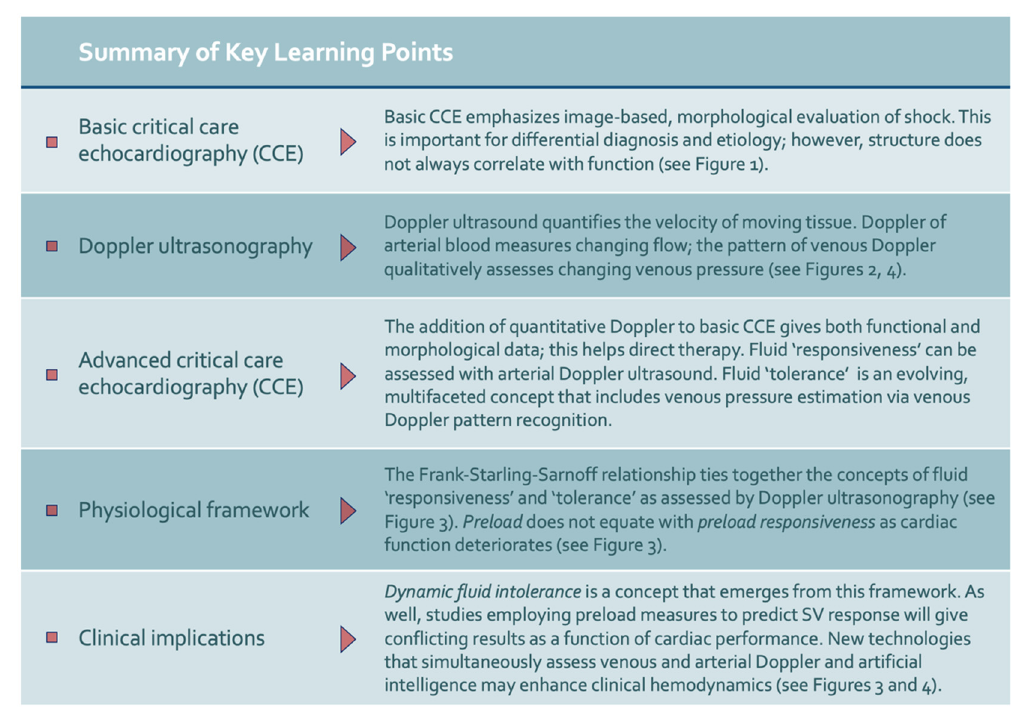
Figure 5. Summary of key learning points.